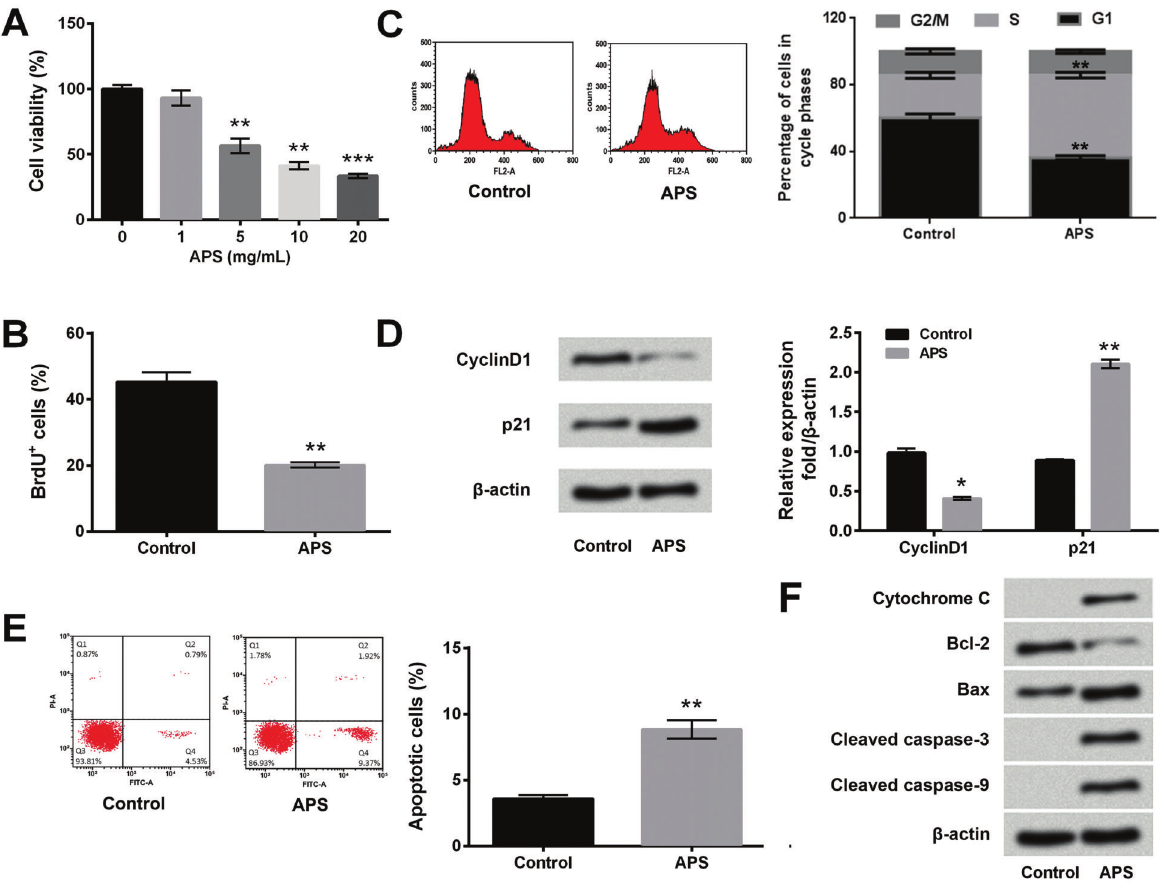
Figure 1. Astragalus polysaccharides (APS) reduced proliferation and induced apoptosis of MG63 cells. MG63 cells were treated by 1 – 20 mg/mL APS. Non-treated cells acted as control. A , Cell viability was detected by CCK-8 assay. B , Percentage of BrdU positive cells was measured by BrdU incorporation assay. C , Cell cycle distribution was assessed using PI staining and fl ow cytometry. D , Expression levels of proliferation-associated proteins were evaluated by western blot analysis. E , Percentage of apoptotic cells was determined by FITC Annexin V/Dead Cell Apoptosis kit and fl ow cytometry. F , Expression levels of apoptosis-associated proteins were evaluated by western blot analysis. Data are reported as means ± SE of three independent experiments. *P o 0.05; **P o 0.01; ***P o 0.001 (ANOVA or t